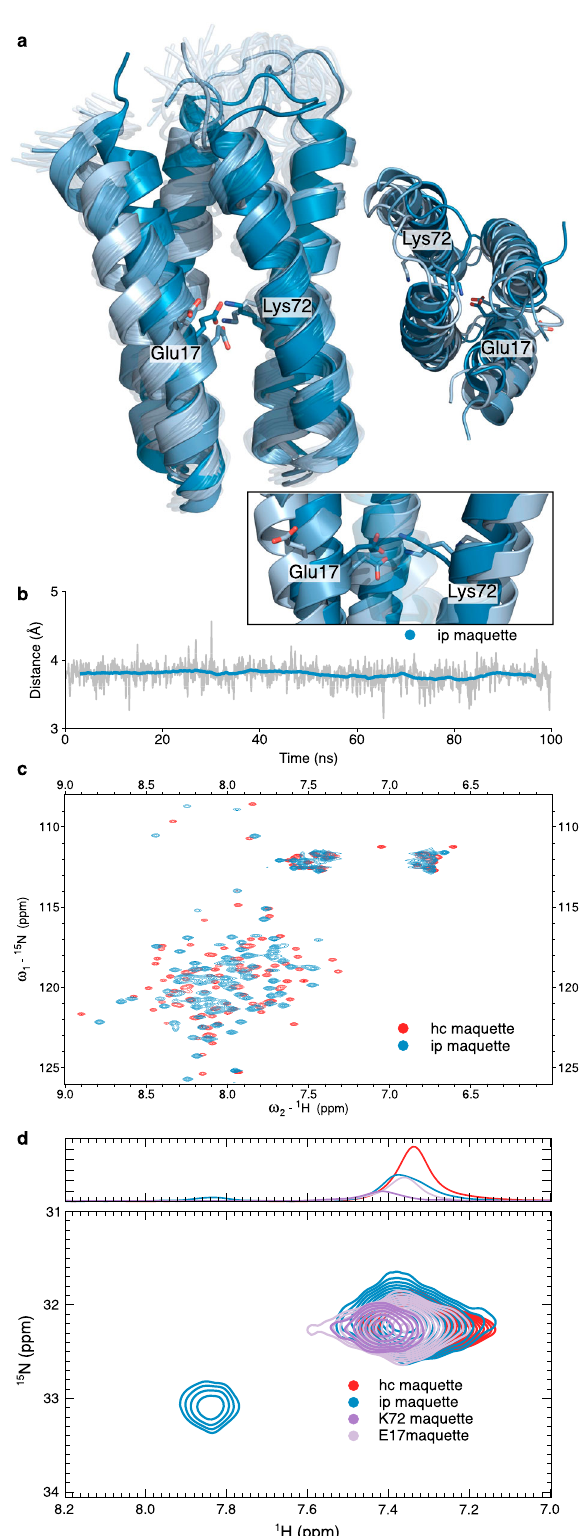
Fig. 2 Biophysical and structural characterisation of ion-pair in Maquette 2. a NMR-structural model of Maquette 2 with an ion-pair at positions 17 and 72 (F17E/F72K) modelled in both closed/open conformations (in dark/pale blue). b Dynamics of the Glu17 and Lys72 ion-pair modelled based on the NMR structure. The shaded line represents the actual data, the coloured line is a moving average over 50 frames. c Heteronuclear single quantum coherence (HSQC) NMR spectrum of Maquette 2 with Glu17-Lys72 ion-pair (ip, F17E/F72K, in blue), and hydrophobic core (hc, in red). d NH 3 -selective HISQC experiment at 275K, indicative of a protected sidechain with slow proton exchange. Glu17-Lys72 ion-pair (ip, F17E/F72K, in blue), hydrophobic core (hc, in red), and single residue substitutions (K72 maquette (E17F) in purple); E17 maquette (K72F), in pale